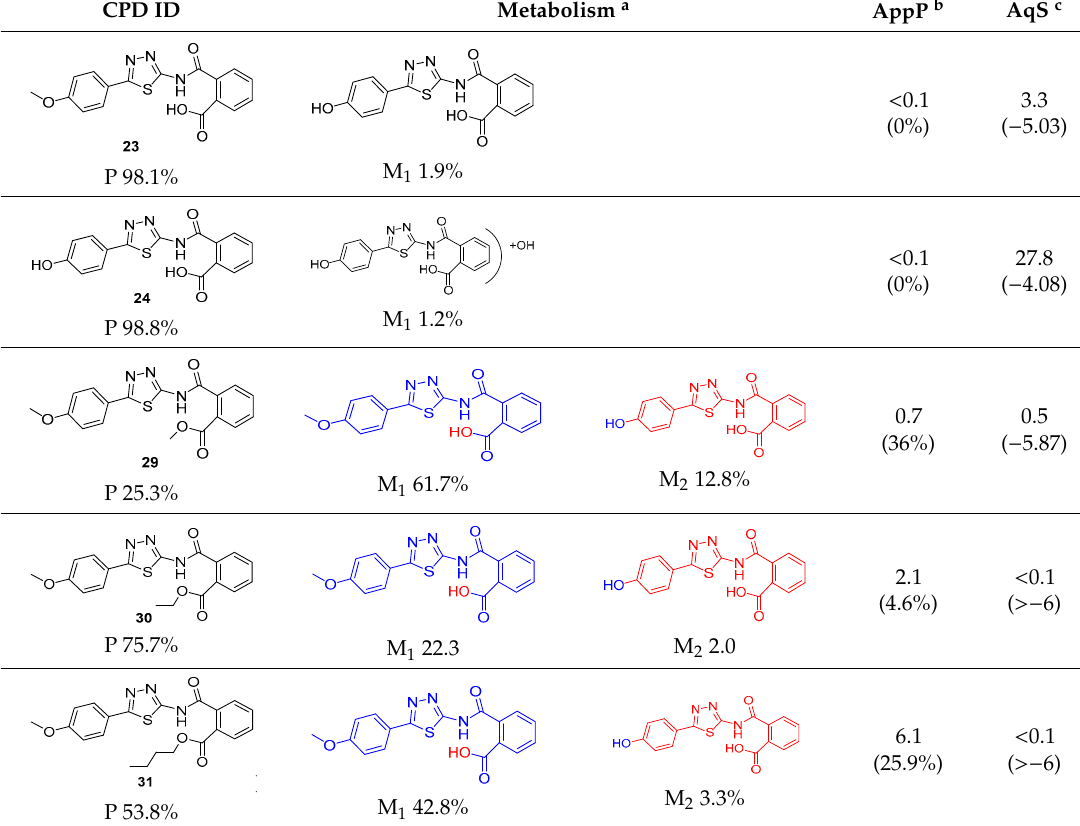
Table 2. In vitro ADME studies of selected compounds.